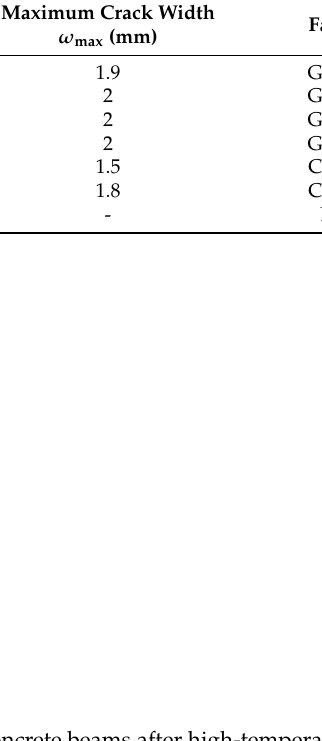
Table 3. Static test results of tested concrete beams.